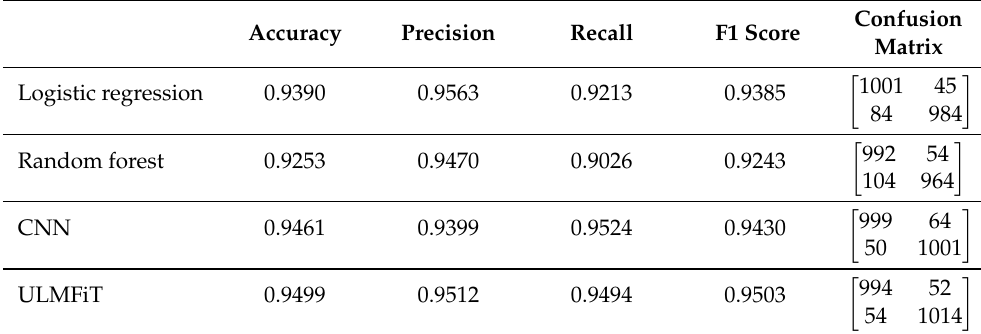
Table 2. Performance measures for the different classifiers with the model variant remove keywords